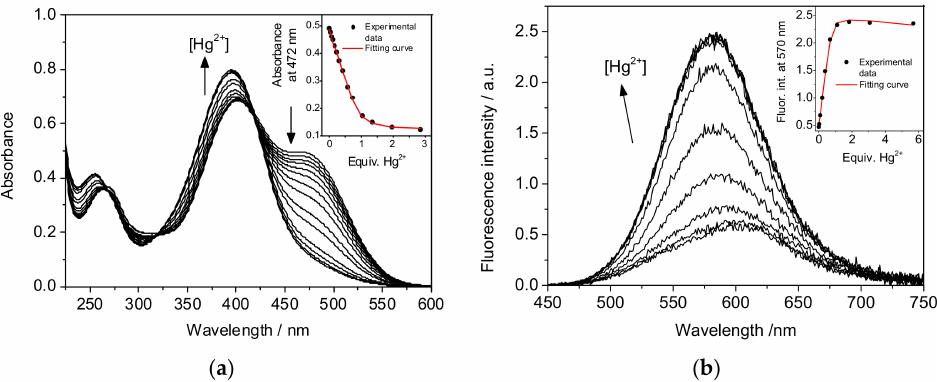
Figure 2. Changes in the absorption ( a ) and fluorescence ( b ) spectra of compound 1 (2 × 10 –5 M) upon addition of aliquots of Hg[ClO 4 ] 2 in water at pH 6.0 (acetate buffer, 0.01M). Excitation wavelength was 380 nm. The upper inserts show the absorbance at 472 nm ( a ) or fluorescence intensity at 570 nm ( b ) versus equivalents of Hg 2+